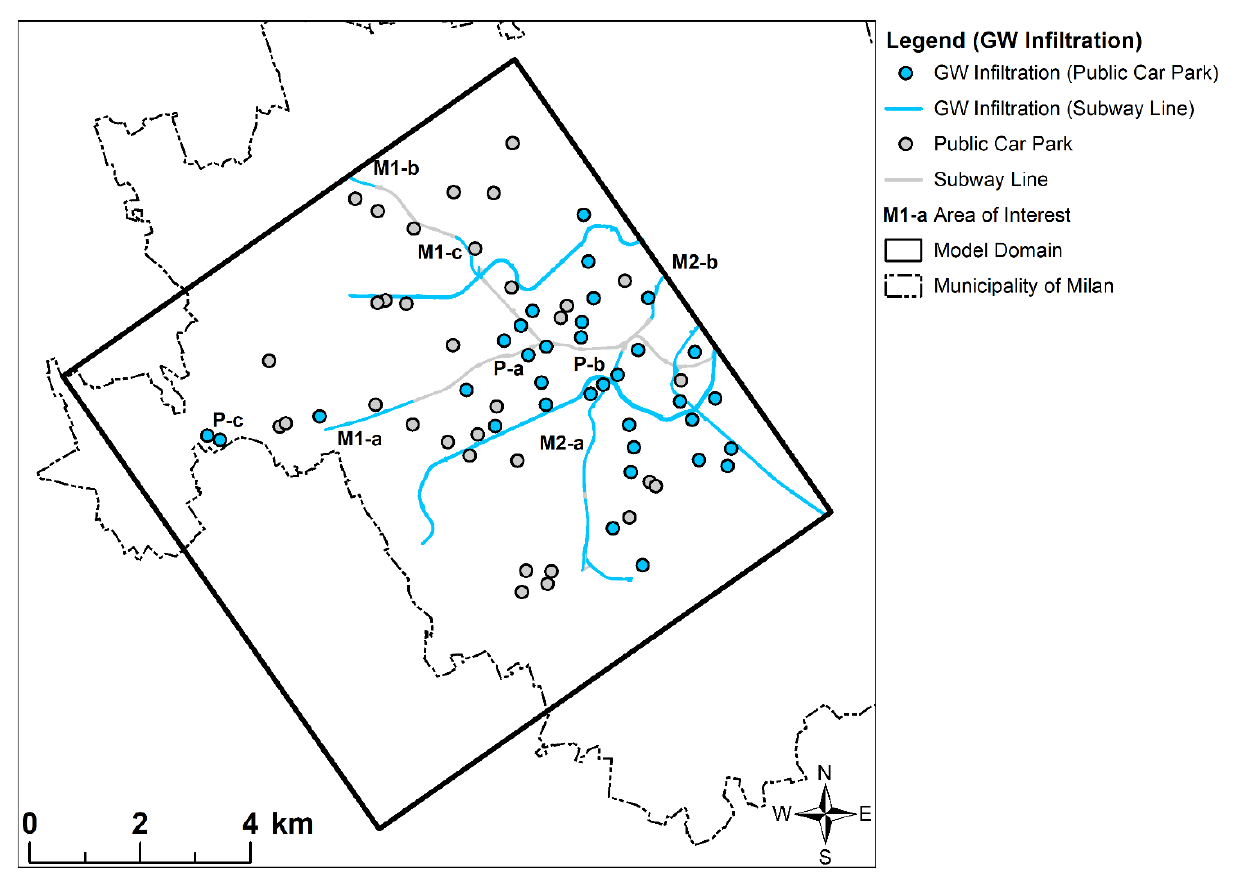
Figure 10. Areas showing GW infiltrations into UIs. Table 4. GW inflows into UIs (m 3 /d) for S1–S3. Please remember that for M3, M4, M5, and parks, K was always set equal to 1.16 × 10 − 3 m/d. Percentage below the water table is intended as the sections of UIs where the bottom of the infrastructure is lower than the hydraulic